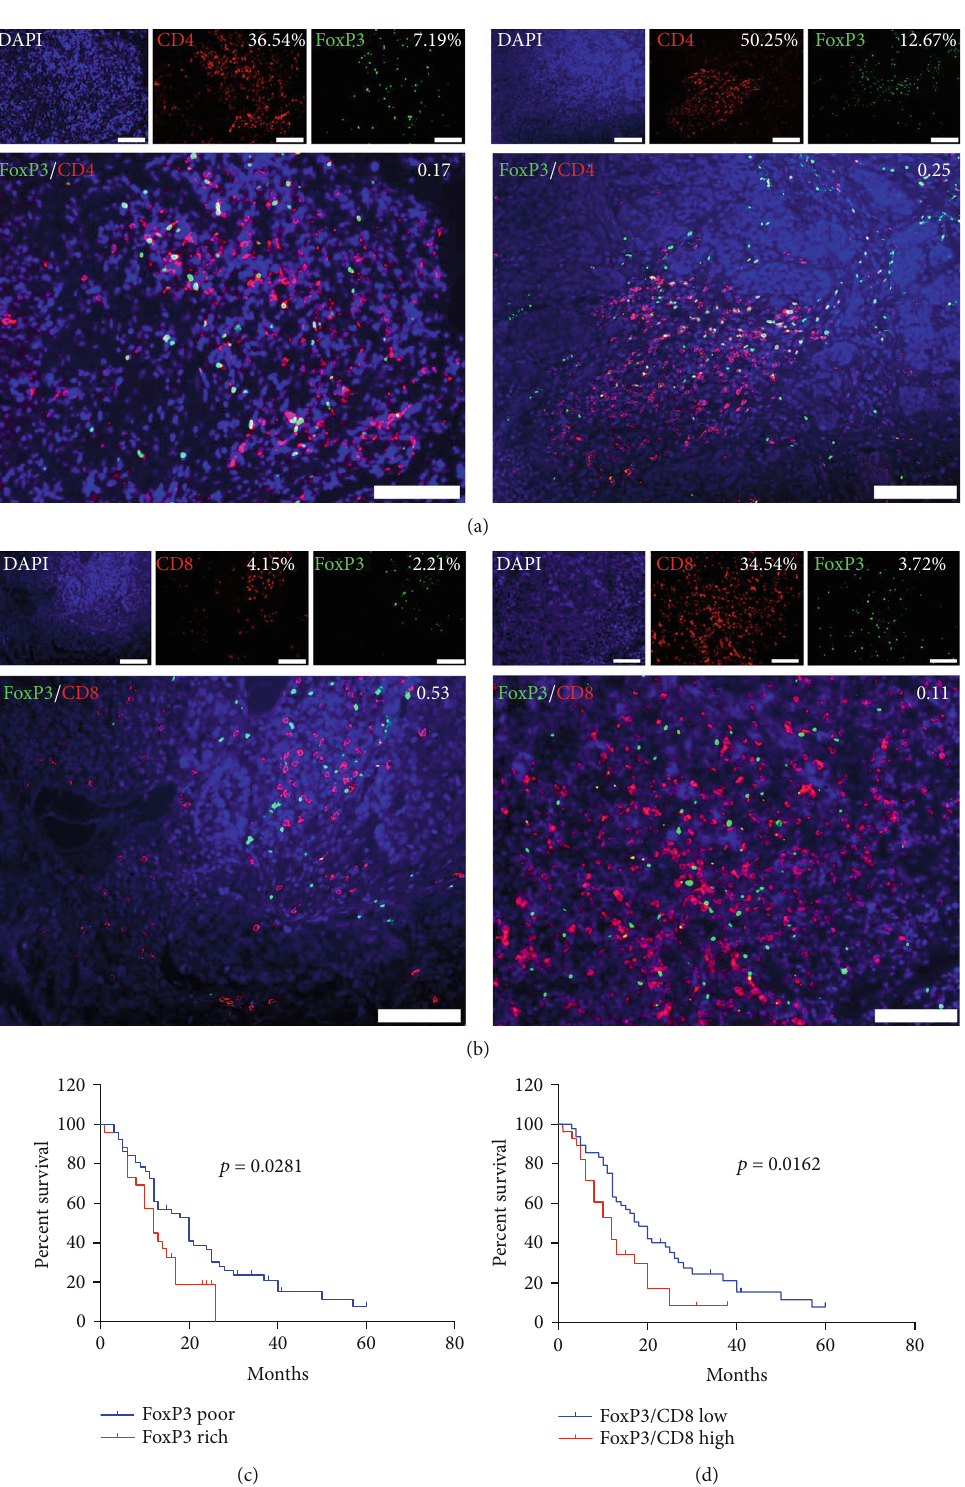
Figure 4: Expression and prognostic value of FoxP3 in PESCC. (a) Representative multi-IF images of two samples showing FoxP3/CD4 ratios in the stroma. Scale bar, 100 μ m. (b) Representative multi-IF images showing two samples with high (left) and low (right) FoxP3/CD8 ratios in stroma. Scale bar, 100 μ m. (c) Rich FoxP3 (red line, n = 26 ) was associated with signi fi cantly shorter OS than poor FoxP3 (blue line, n = 51 ). (d) A high FoxP3/CD8 ratio (red line, n = 28 ) was associated with shorter OS than a low FoxP3/CD8 ratio (blue line, n = 49